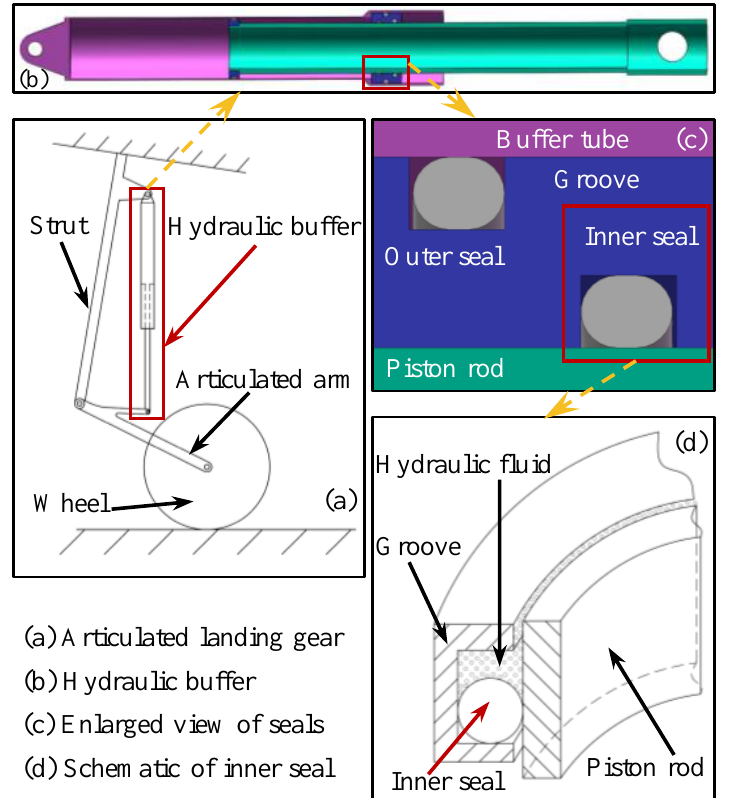
Figure 1. Schematic of seals for articulated landing gear. The hydraulic buffer is a key structure of load-bearing in the articulated landing gear. And the hydraulic buffer of articulated landing gear is composed of buffer tube, groove, seals, and piston rod. To prevent the leakage of hydraulic fluid, the rubber O-rings are used as the inner seal and outer